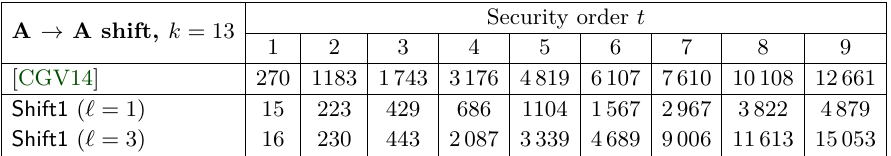
Table 13: Number of cycles to perform an arithmetic to arithmetic shift by ‘ positions where ‘ = 1 and ‘ = 3, with input arithmetic values modulo 2 k where k = 13.